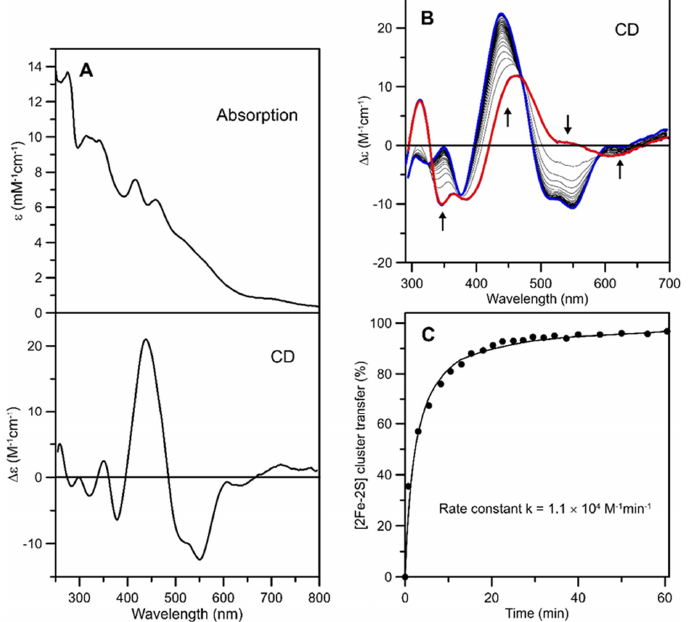
Figure 4. Cluster transfer from At [2Fe-2S] 2+ -GRXS15 to At apo-mFDX1 monitored by CD spectroscopy as a function of time. ( A ) Room temperature UV-visible absorption and CD spectra of [2Fe-2S] 2+ cluster-bound as-isolated At mFDX1. ( B ) CD spectra of the cluster transfer reaction mixture that was initially 40 μ M in GRXS15 [2Fe-2S] 2+ clusters and 40 μ M in apo-mFDX1. The thick red line corresponds to [2Fe-2S] 2+ -GRXS15 recorded before addition of apo-mFDX1. The thin grey lines correspond to CD spectra recorded at 1, 3, 5, 8, 10, 13, 15, 17, 20, 22, 25, 27, 30, 32, 34, 37, 40, 45, 50, 56, 60, 69, 75, 86, 95, 101, 105, 110 and 120 min after the addition of apo-mFDX1. The thick blue line corresponds to complete [2Fe-2S] 2+ cluster transfer to mFDX1. The arrows indicate the direction of intensity change with increasing time at selected wavelengths and Δε values were calculated based on the initial concentration of [2Fe-2S] 2+ clusters. The cluster transfer reaction was carried out under anaerobic conditions at room temperature in 100 mM Tris-HCl buffer at pH 7.8. ( C ) Kinetic simulation of cluster transfer from [2Fe-2S] 2+ -GRXS15 to apo-mFDX1 based on second-order kinetics and the initial concentrations of [2Fe-2S] 2+ clusters on [2Fe-2S] 2+ -GRXS15 and of apo-mFDX1. Percent cluster transfer was assessed by CD intensity at 550 nm (black circles) and simulated with a second-order rate constant of 1.1 × 10 4 M − 1 min − 1 .